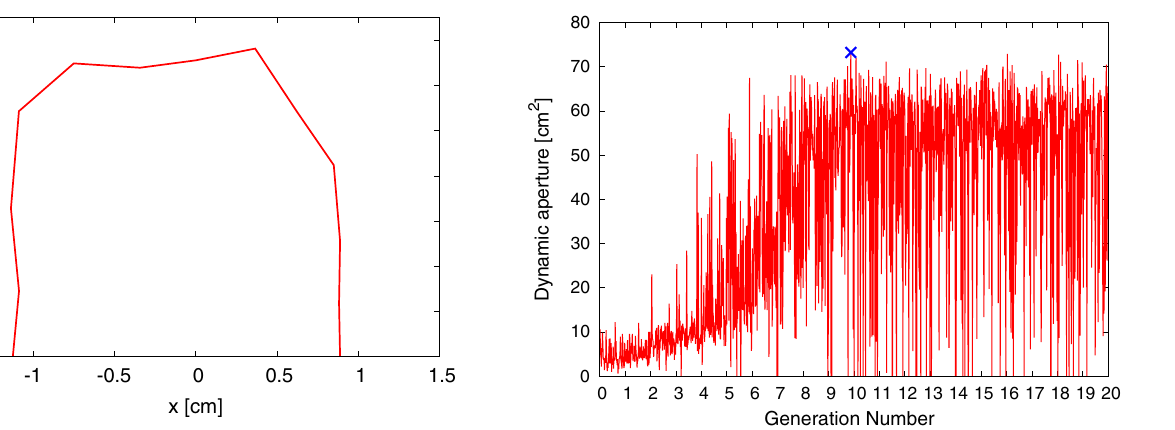
FIG. 9. Maximization of the dynamic aperture for the MEIC ion collider ring: 64 individuals sampling the ½ 0 ; 1 (cid:6) 2 domain, evolved using GA over 20 generations. The blue (cid:5) denotes the maximum value of the dynamic aperture.